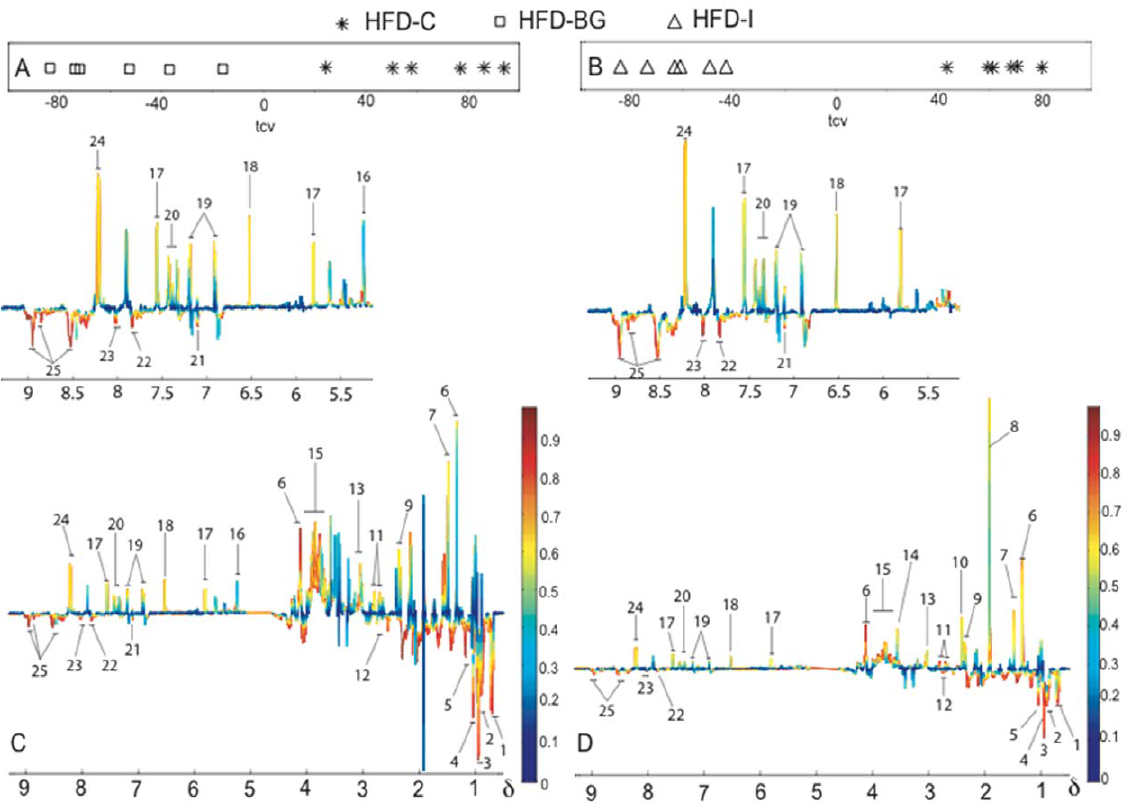
Figure 5. Multivariate statistical analysis of the fecal 1 H NMR spectra. OPLS-DA cross validated scores plots for mice fed with (a) HFD-C and HDF-BG; and (b) HFD-C and HFD-I. The corresponding coefficient plots indicated fecal metabolic differences for (c) HFD-C and HFD-BG; and (d) HFD-C and HFD-I. Insets show an expansion of the aromatic region. HFD-C, high fat diet control; HFD-I, high fat diet + inulin; HFD-BG, high fat diet + b -glucan. 1, Bile acids; 2, Butyrate; 3, Isoleucine, leucine and valine; 4, Propionate (tentative); 5, Unknown at d 1.17 (doublets) ; 6, Lactate; 7, Alanine; 8, Acetate; 9 Glutamate (tentative); 10, Succinate; 11, Aspartate; 12, Citrate; 13, Lysine; 14, Glycine; 15, Glucose and amino acids; 16, Glucose; 17, Uracil; 18, Fumarate; 19, Thyrosine; 20, Phenylalanine; 21, Histidine; 22, Unknown at d 7.84 (doublets); 23, Unknown at d 8.02 (doublets); 24, Unknown at d 8.20 (doublets); 25, Amine related compounds.